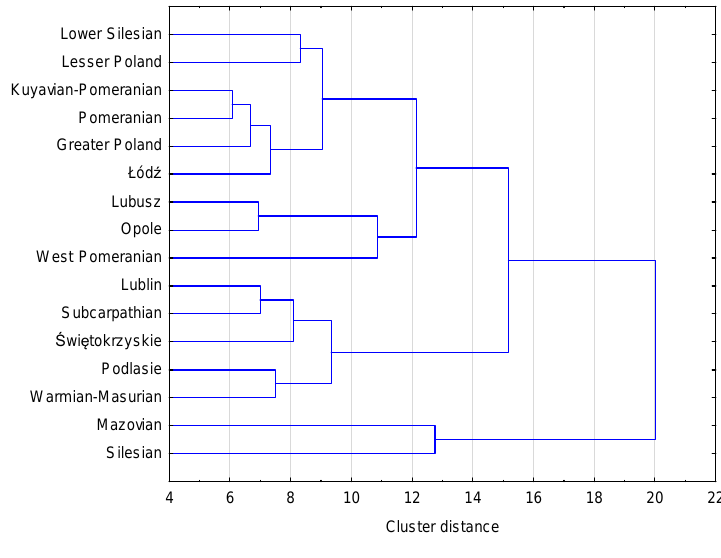
Figure 3. Clusters of Polish Voivodeships with similar social and economic development levels in 2010.